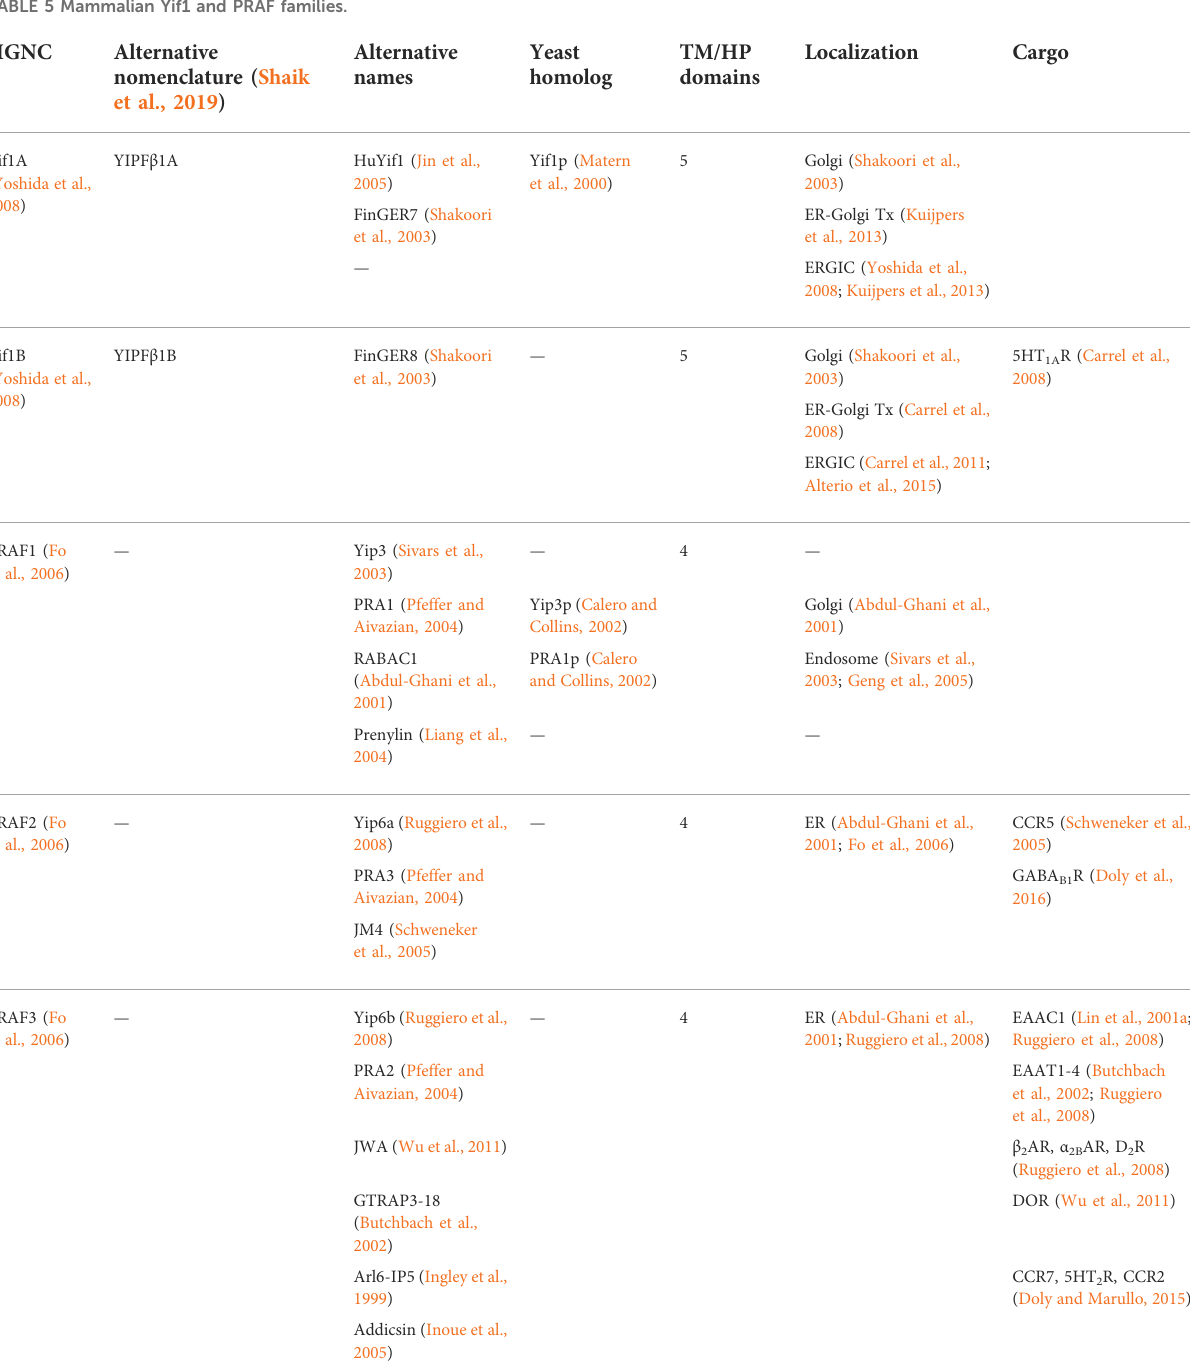
TABLE 5 Mammalian Yif1 and PRAF